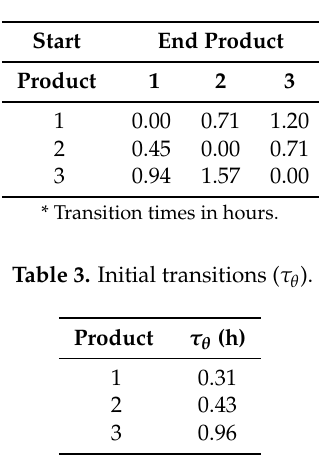
Table 2. Transition time table ( τ ss ) *.